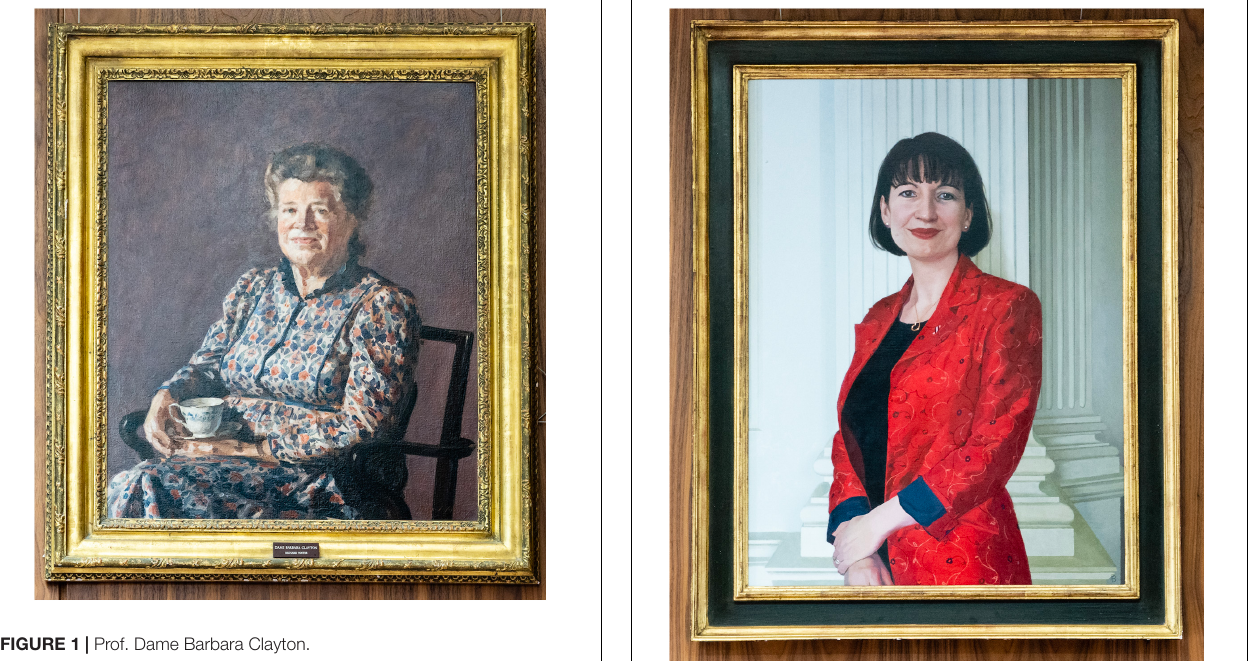
FIGURE 1 | Prof. Dame Barbara Clayton.